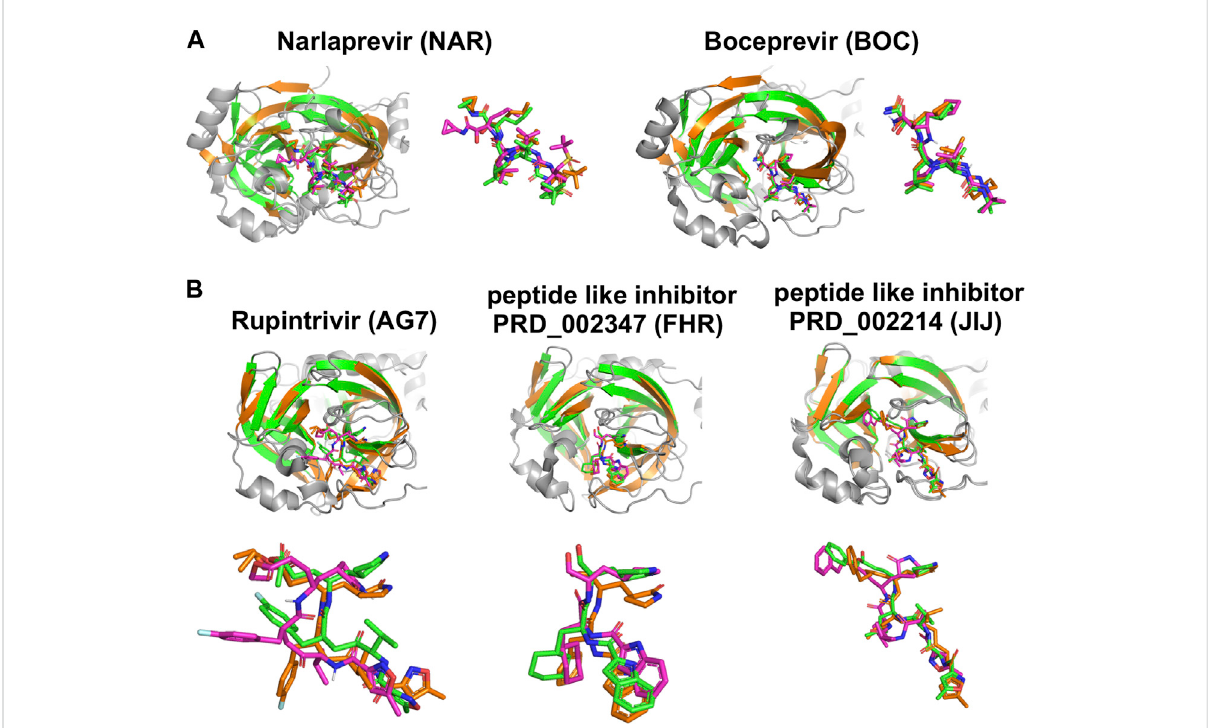
FIGURE 7 Comparisons of experimentally-determined structures and predicted docking poses of drugs and inhibitors bound to SARS-CoV2 3CL pro and other viral proteases. (A) Comparison of the HCV NS3/4A protease inhibitors NAR and BOC binding pose in AutoDock (magenta) with the X-ray crystal structure in complex with SARS-CoV2 3CL pro (green, NAR (PDB: 6XQT) and BOC (PDB: 6XQU)) and X-ray crystal structure in complex with HCV NS3/4A protease (orange, NAR (PDB: 3LON) and BOC (PDB: 3LOX)). (B) Comparison of inhibitor binding poses in AutoDock (magenta) with, X-ray crystal structures of complexes with SARS-CoV2 3CL pro (green, AG7 (PDB: 7L8J), FHR (PDB: 6LZE), N3 (PDB: 7BQY)) and X-ray